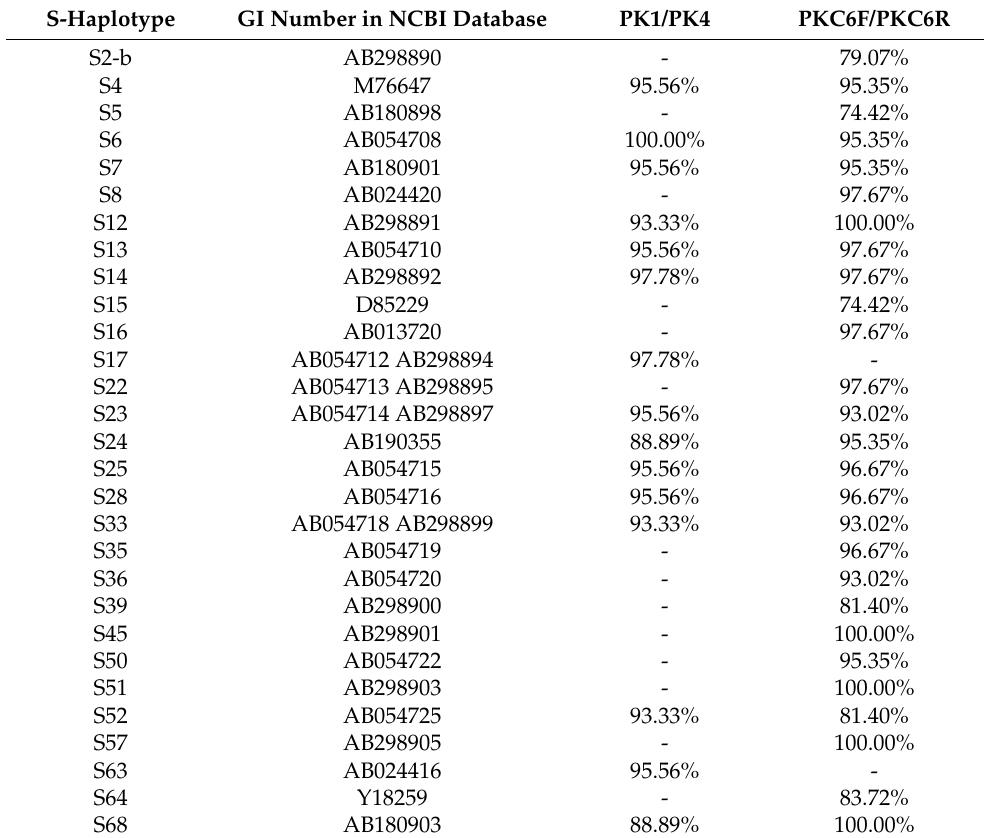
Table 1. The matching degrees of primers with S-haplotype sequences.